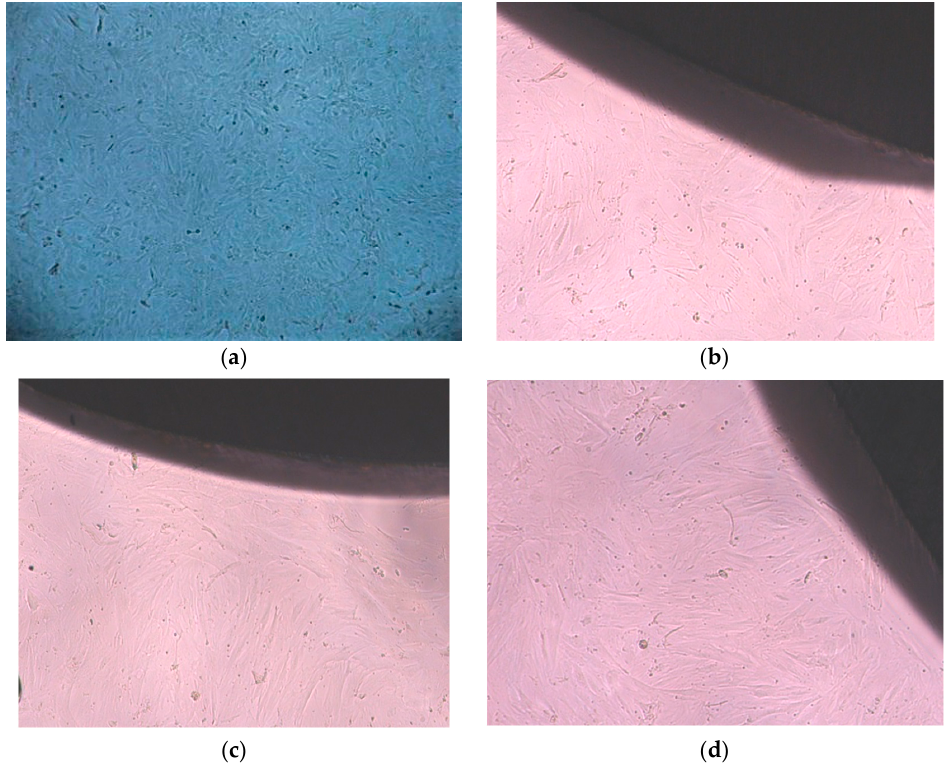
Figure 6. Morphology of MSCs in the control sample (without metallic specimen) ( a ) and Ti30Nb20 ( b ), Ti40Nb10 ( c ), and Ti50Nb0 ( d ) alloys. Magnification was ×100.